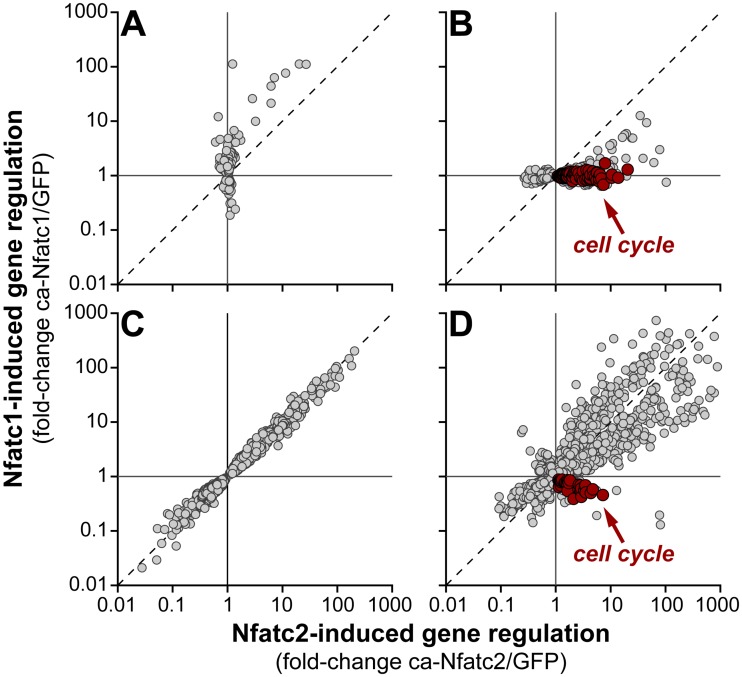
Nfatc1 vs. Nfatc2-mediated gene regulation in mouse islets.Whole-islet RNA-sequencing was used to profile gene expression 48 hr after overexpression of ca-Nfatc1, ca-Nfatc2 or GFP (negative control). Genes that were differentially expressed (DE) were classified into one of 4 distinct patterns (relative to GFP): A, DE in response to ca-Nfatc1 only (518 genes); B, DE in response to ca-Nfatc2 only (1580 genes); C, equally DE for ca-Nfatc1 and ca-Nfatc2 (2293 genes); and D, unequally DE for ca-Nfatc1 and ca-Nfatc2 (2621 genes). Gene sets enriched with cell cycle regulatory transcripts are highlighted in red. Expression values for all genes and isoforms are contained within S7 Table.